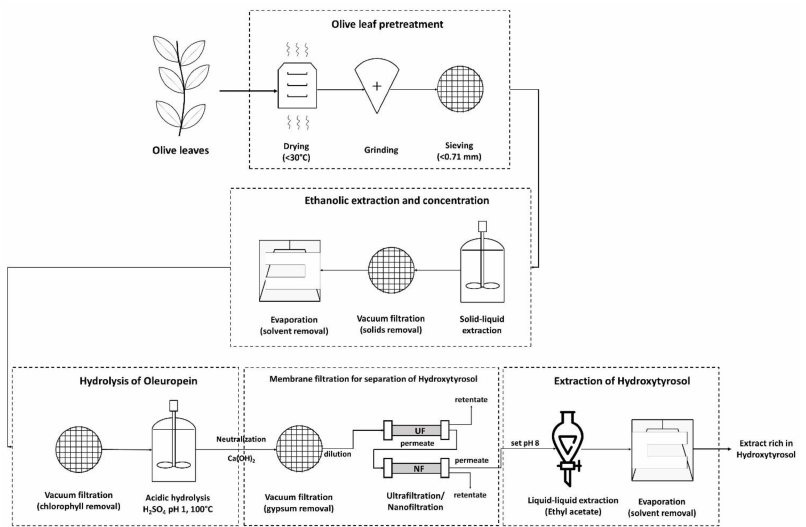
Figure 5. Process scheme in which the membrane filtration step took place after the acidic hydrolysis.